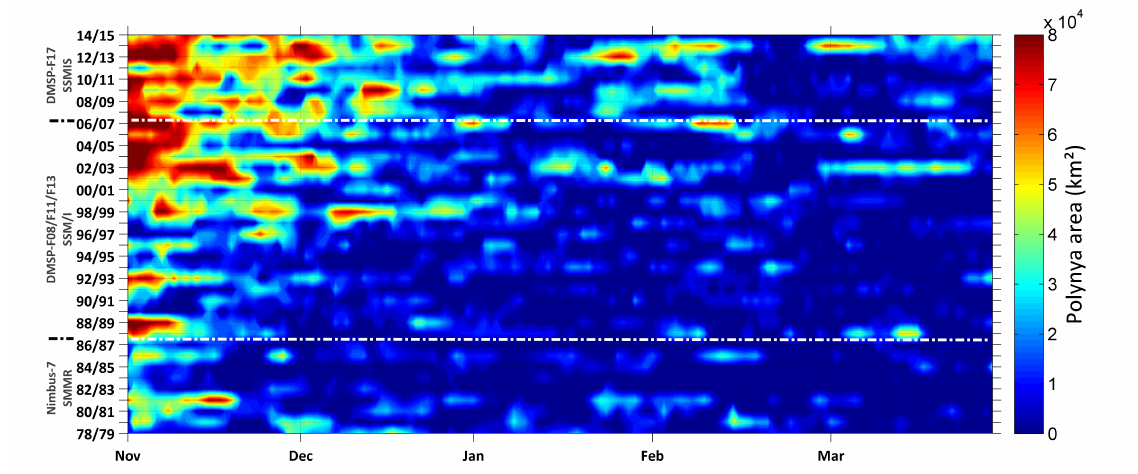
Figure 4. Hovmöller diagram of daily polynya area (POLA SSMI,70PT ) in the North Water Polynya between 1978/1979 and 2014/2015. White horizontal dotted lines indicate changing sensors in the sea ice concentration (SIC) dataset by Cavalieri et al.